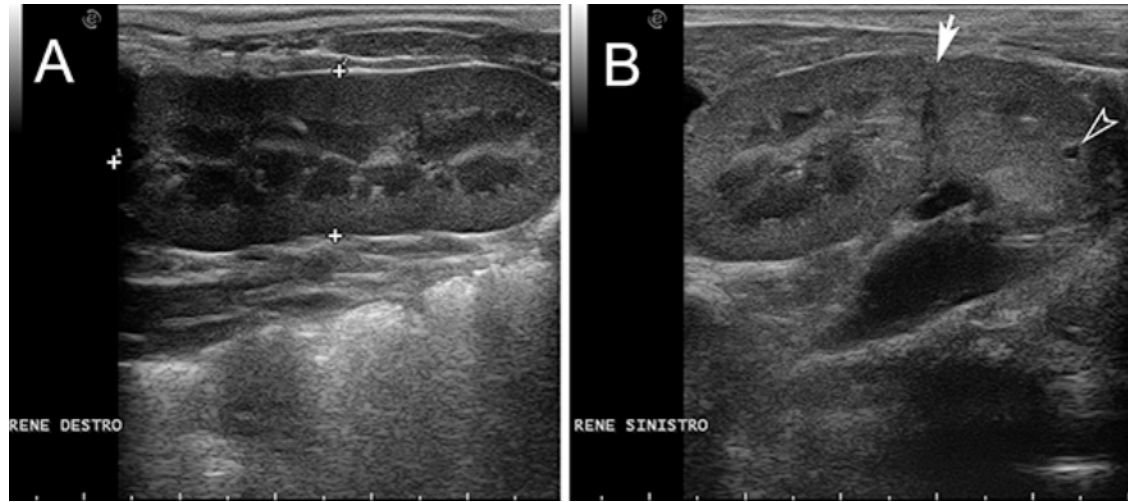
Figure 5. Ultrasonographic exam of the right ( A ) and left kidney ( B ) in a sagittal scan. The right kidney has an overall normal echo-structure. The left kidney has a bended shape with a deep notch at the level of the median region (arrow). At the caudal pole, it is visible a small cyst (arrowhead).